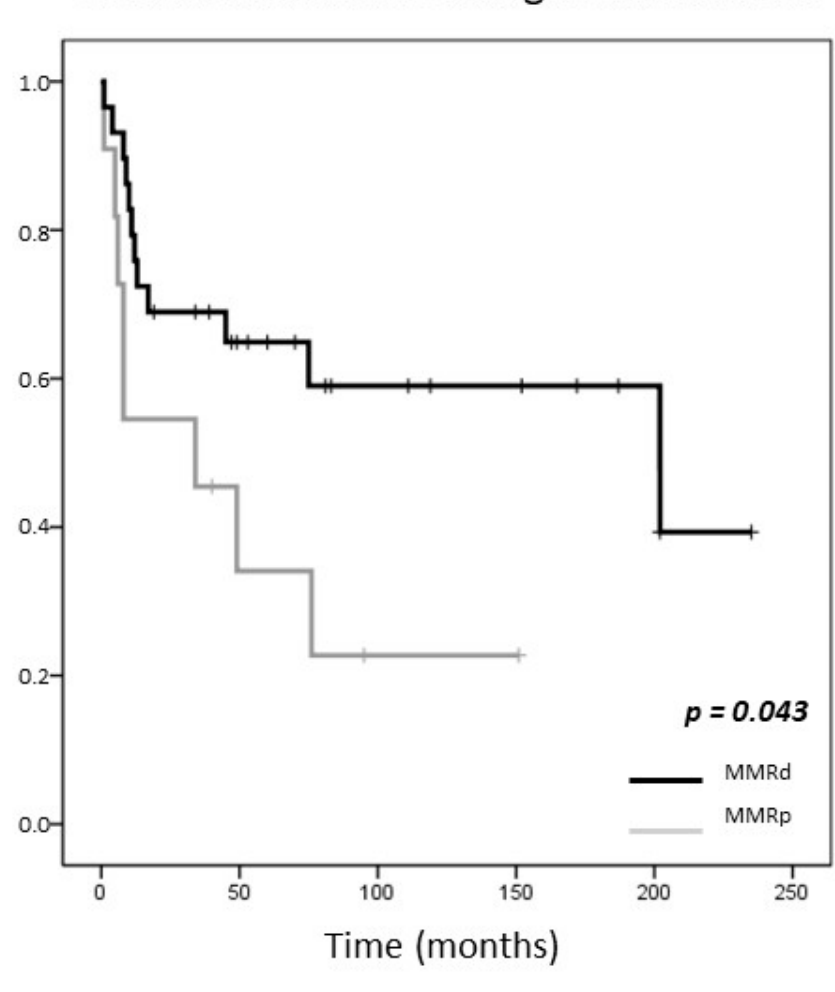
Figure 7. Kaplan-Meier curve for overall survival according to the mismatch repair status.